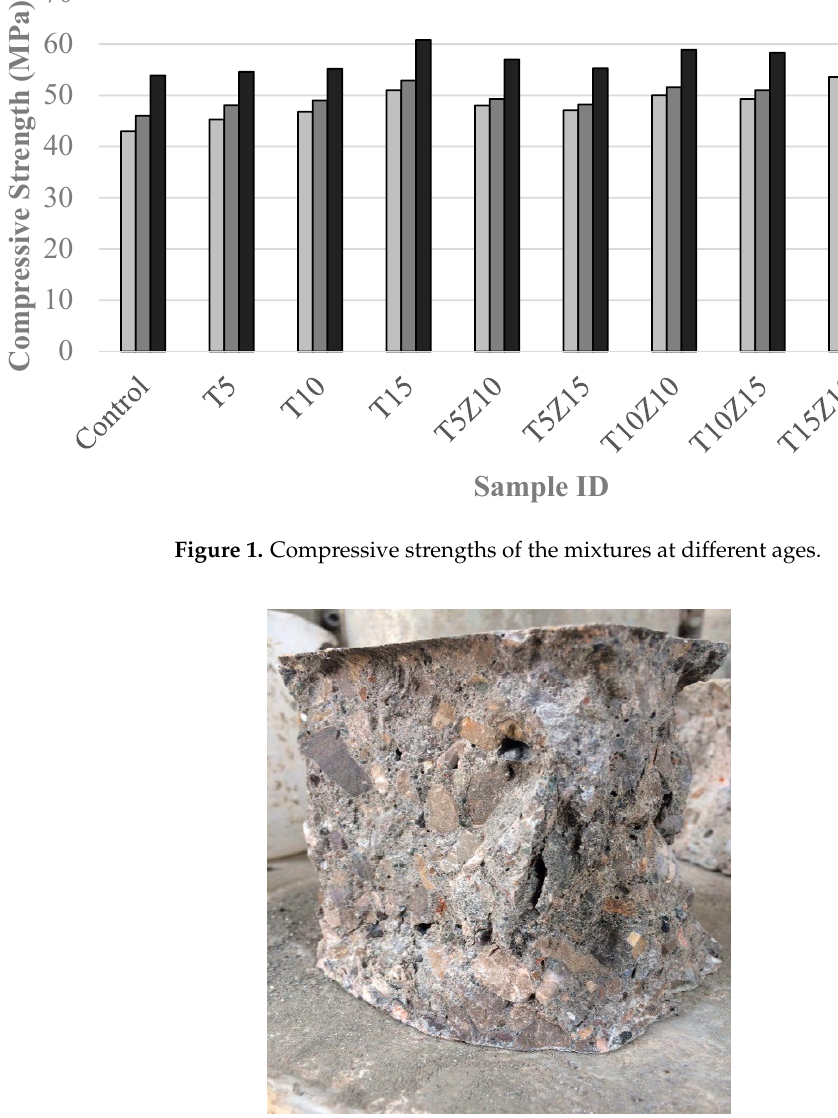
Figure 2. The fractured face of a sample containing 10% zeolite and 15% tuff after compressive strength test.